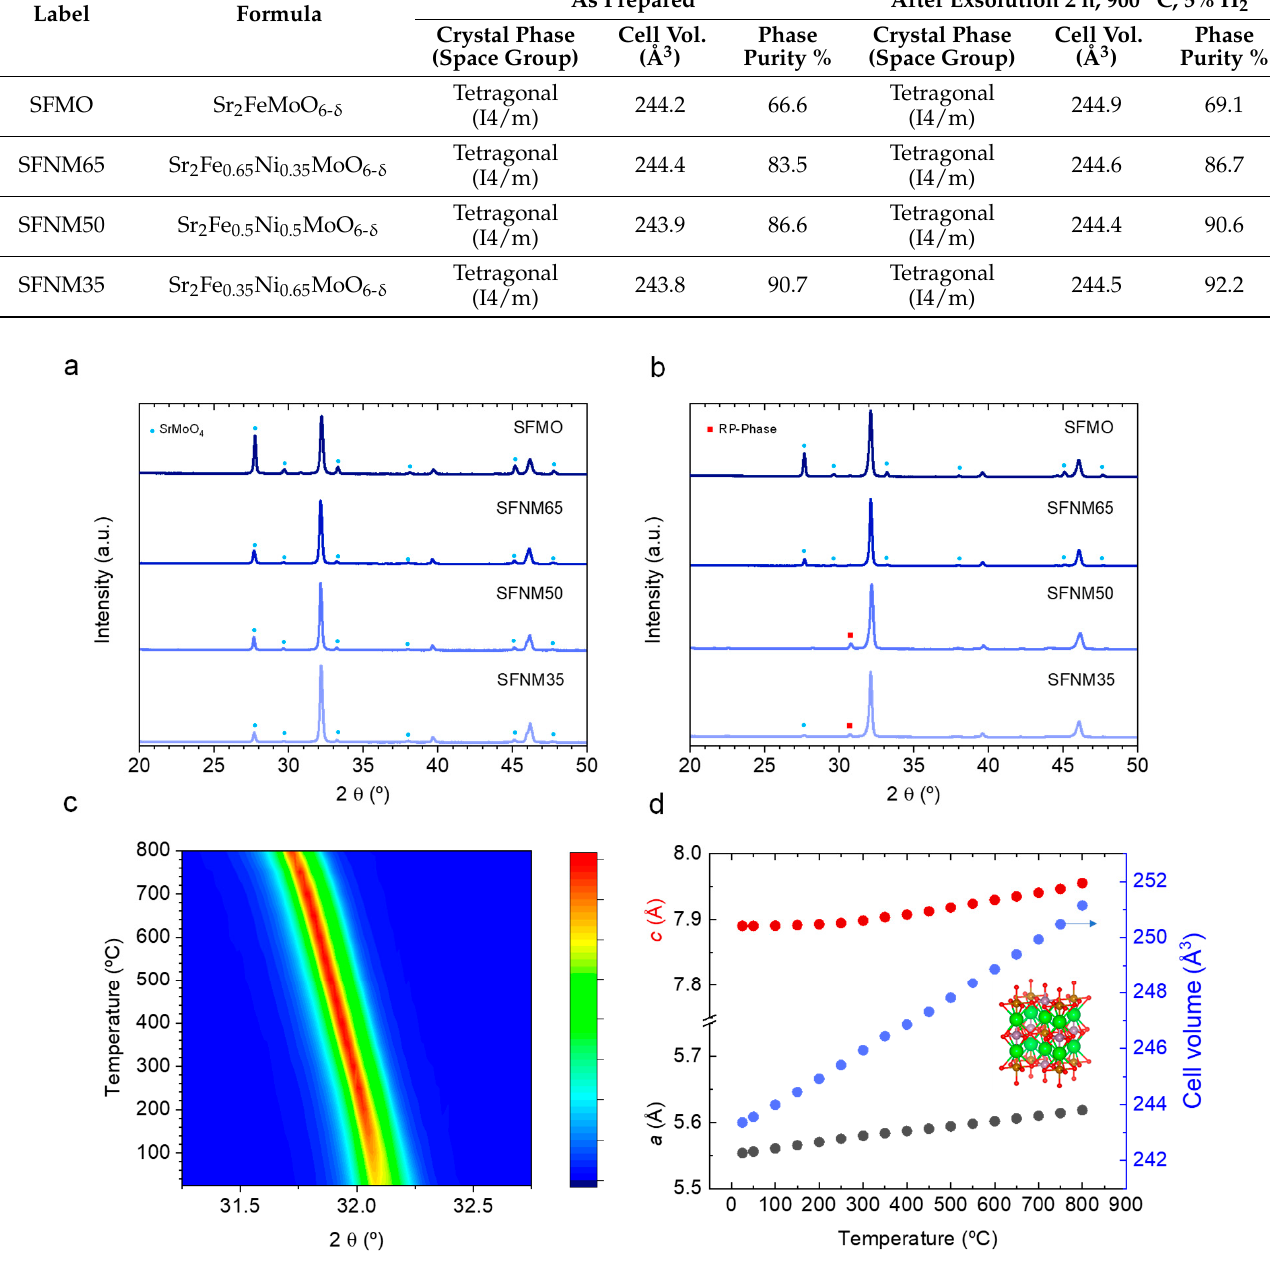
Figure 2. ( a ) XRD diffractograms of the Sr 2 Fe x Ni 1-x MoO 6- δ materials as-synthesized (calcination at 1100 ◦ C in air). ( b ) XRD diffractograms of the Sr 2 Fe x Ni 1-x MoO 6- δ materials after the exsolution treatment (5% H 2 , 900 ◦ C, 2 h). ( c ) In situ XRD experiment performed to SFNM50, heating up to 800 ◦ C under 5% H 2 . The selected zone depicts the most intense reflection of the tetragonal double layer perovskite. ( d ) Tetragonal lattice parameters ( a , c ) and lattice volume variation extracted from the in situ XRD tests for the SFNM50 sample. The schematic inside the figure depicts the tetragonal double layer perovskite crystalline structure (green, red, purple, and brown spheres are Sr, O, Mo, and Fe/Ni atoms, respectively).